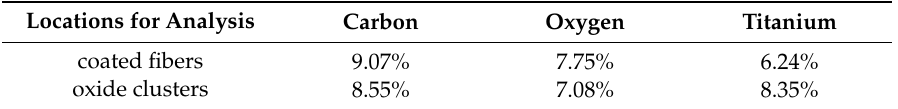
Table 3. Composition analysis statistical results showing the standard deviation of atomic mass content from the energy dispersive X-ray di ff raction spot analysis of 15